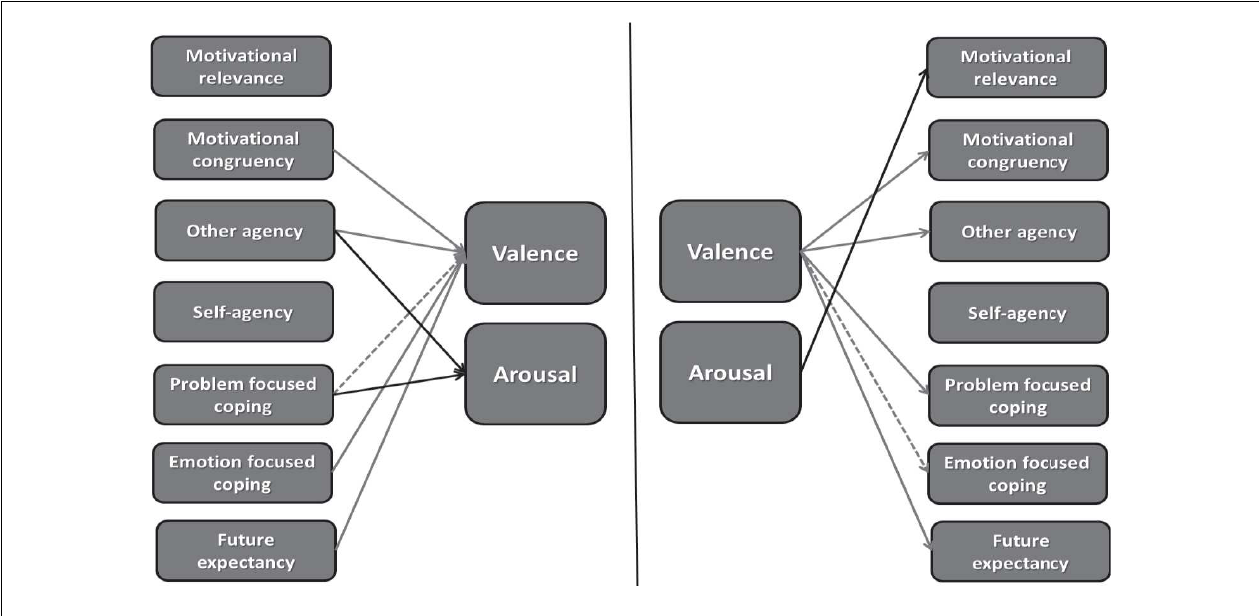
FIGURE 1 | Graphical summary of directional appraisal-core affect (left panel) and core affect-appraisal relationships (right panel) based on separate analyses each involving one core affect